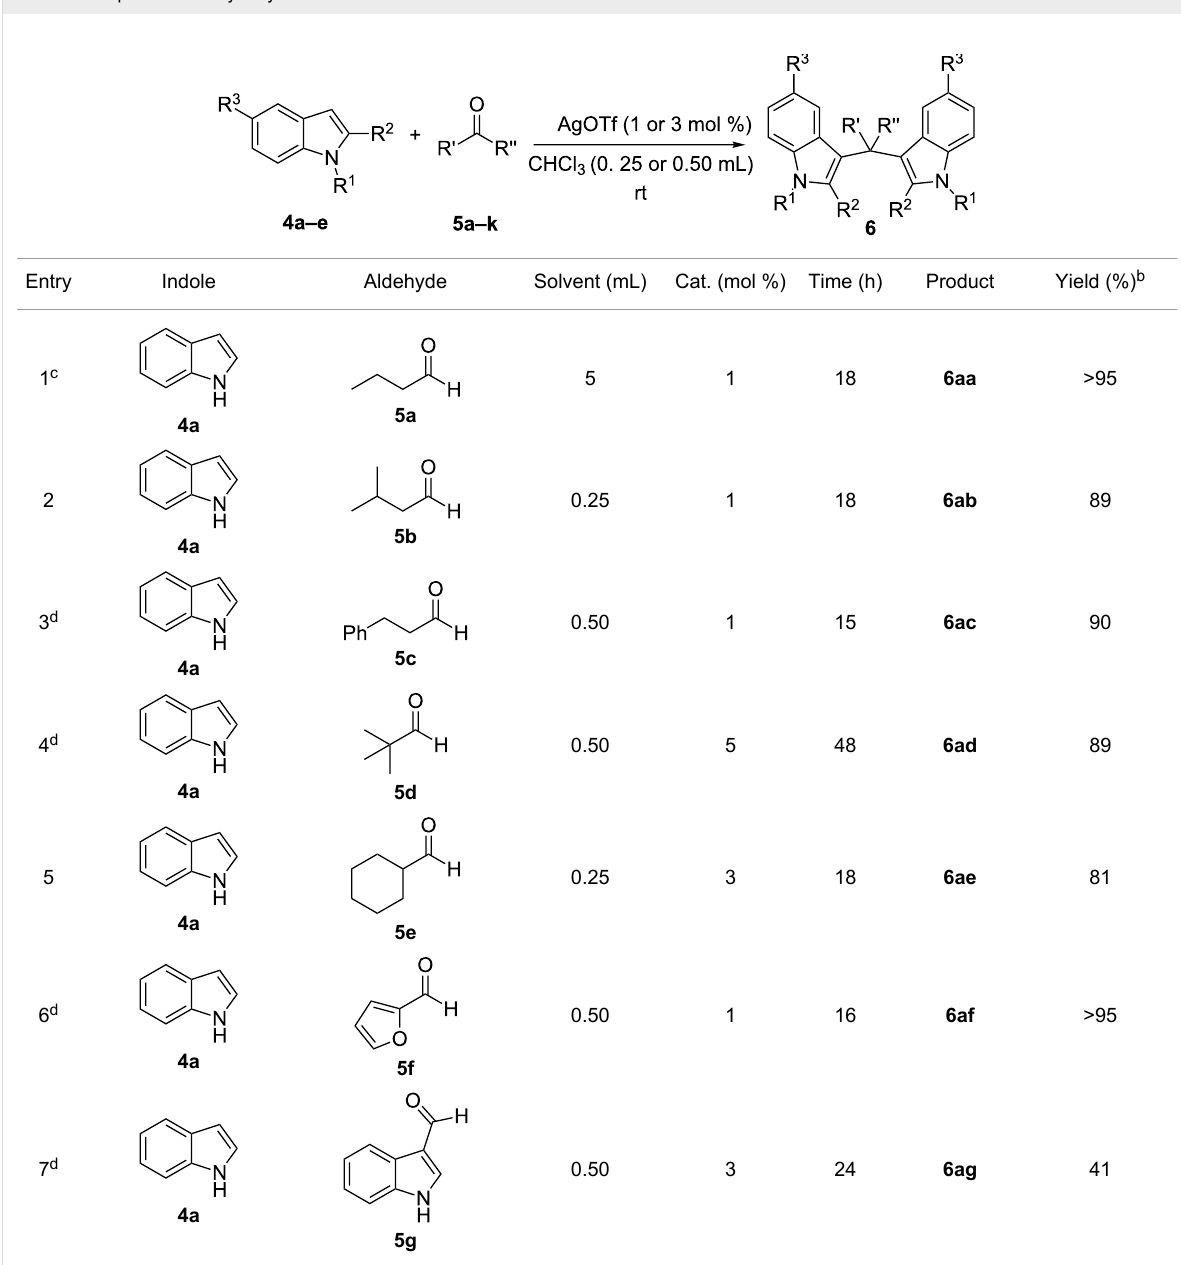
Table 2: Scope of the catalytic synthesis of BIM derivatives 6 . a